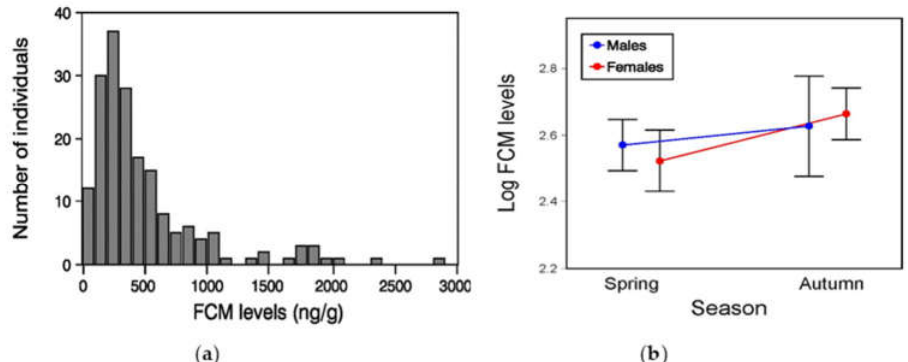
Figure 3. ( a ) Frequency distribution of baseline levels of fecal corticosterone metabolites (FCM; ng/g dry excrement) of individual T wiegmanni amphisbaenians; ( b ) Sex and seasonal variation in mean ( ± SE) log 10 -transformed FCM levels.